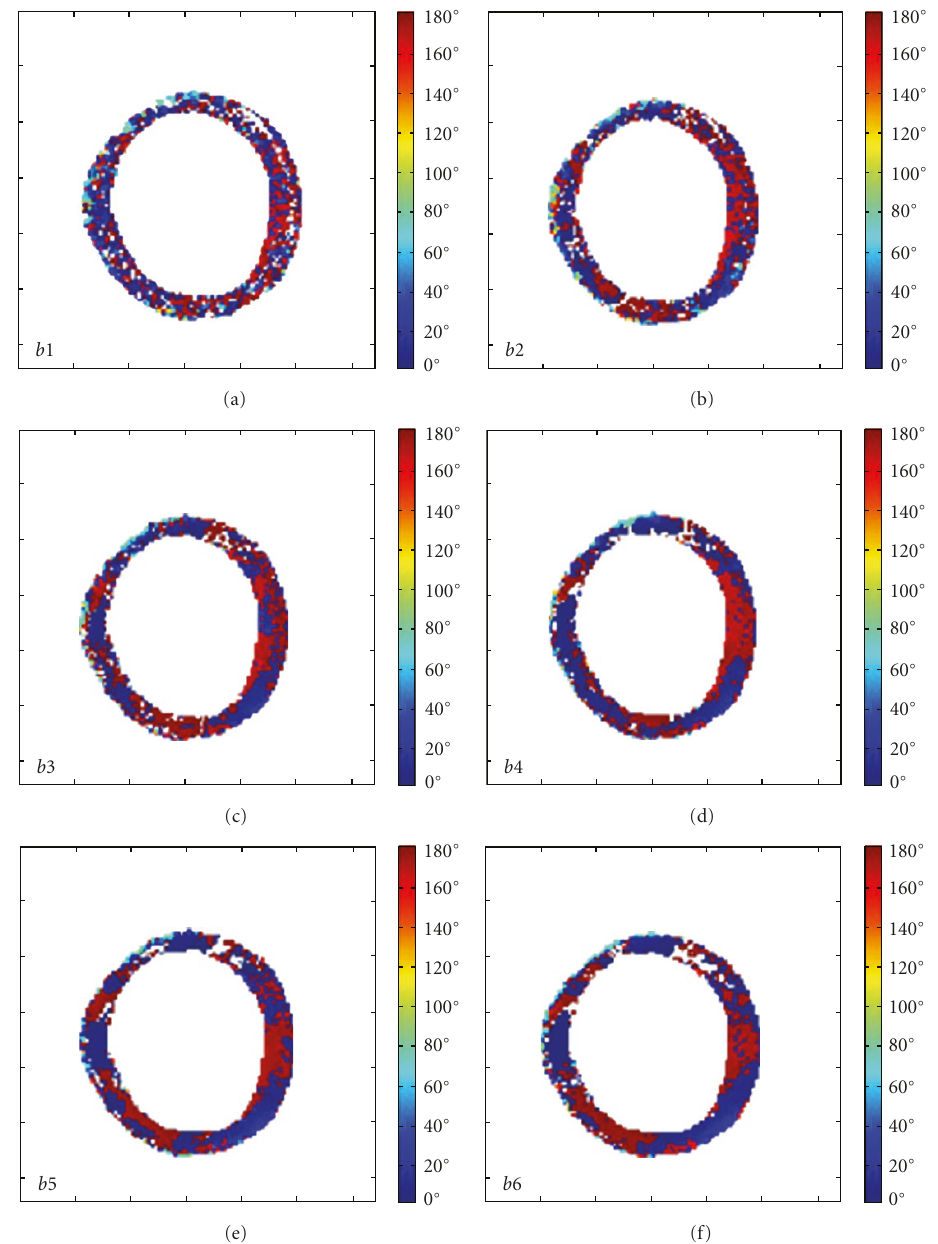
Figure 4: Contour maps of the angle between the first eigenvector and the x-y plane for the central slices of the image data sets for the di ff erent b